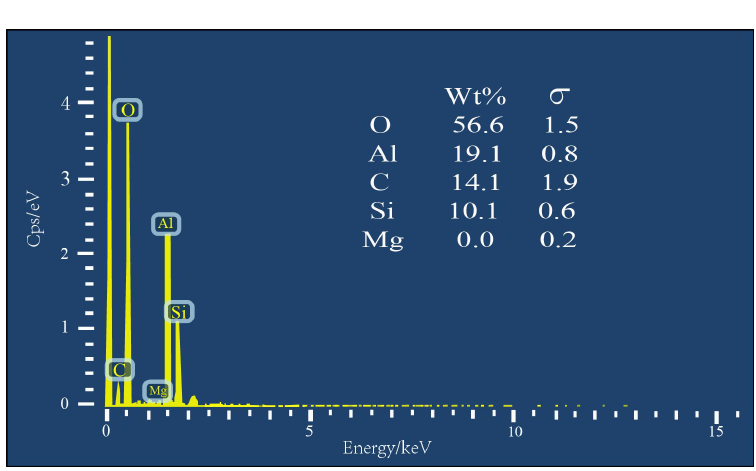
Figure 6. Energy dispersive spectrometer (EDS) spectrum of silicone rubber powder.